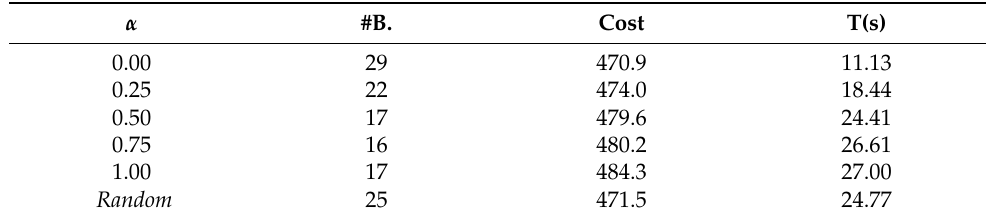
Table 2. Performance of the different values of α for the proposed constructive method coupled with the local search after 10,000